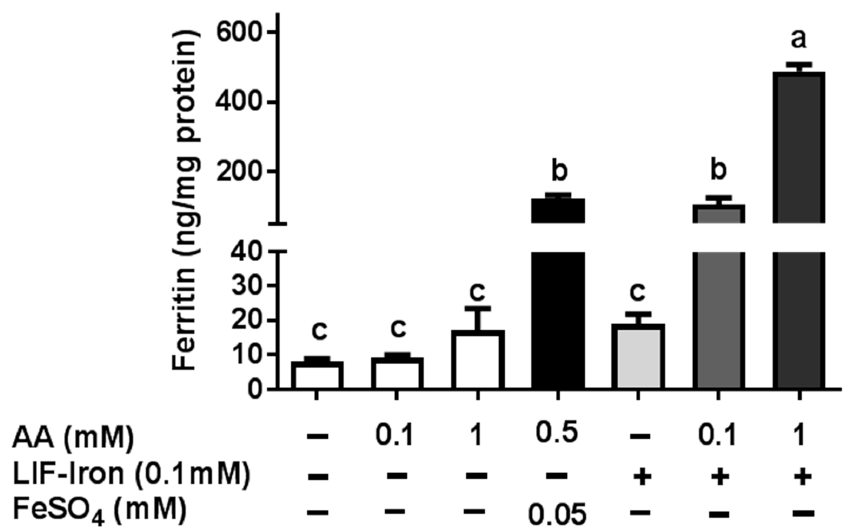
Figure 4. Cellular ferritin response, as a surrogate of the iron uptake, from the iron ingot (Lucky Iron Fish™ (LIF)) with or without ascorbic acid (AA). Caco-2 cells were exposed for 24 h to the LIF-iron (0.1 mM Fe) with the indicated concentration of AA. Data represent means ± SEM ( n = 6–8). Different letters indicate statistically significant differences ( p < 0.05).